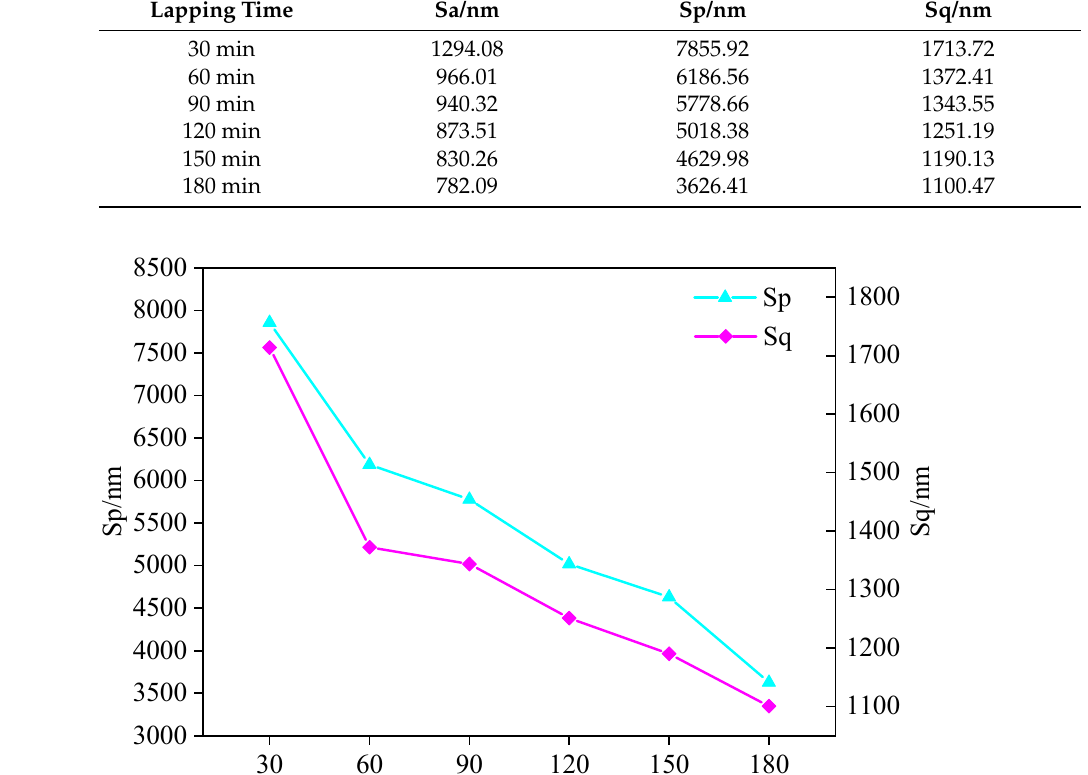
Figure 7. The three-dimensional surface parameters Sp and Sq of FAP at each processing stage.